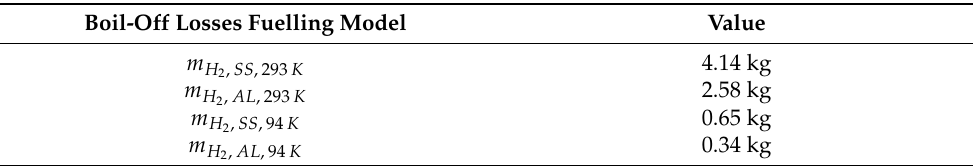
Table 5. Boil-off losses Fuelling Model.